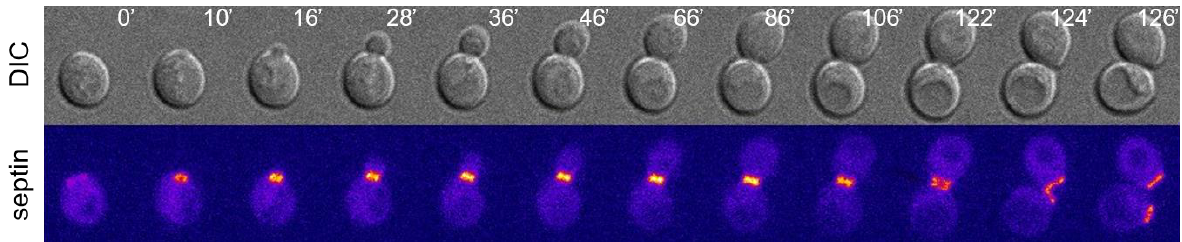
FIGURE 1: The budding yeast septin collar during the cell cycle. Wild type cells expressing the septin Cdc12 tagged with GFP were imaged at 30°C and Z-stacks were max- projected and pseudocoloured “fire” with Image J. S eptins appear at the presumptive bud site in unbud- ded cells (t=10’) and the septin collar splits in late mitosis (t=122’, white arrow). DIC: differential interference contrast